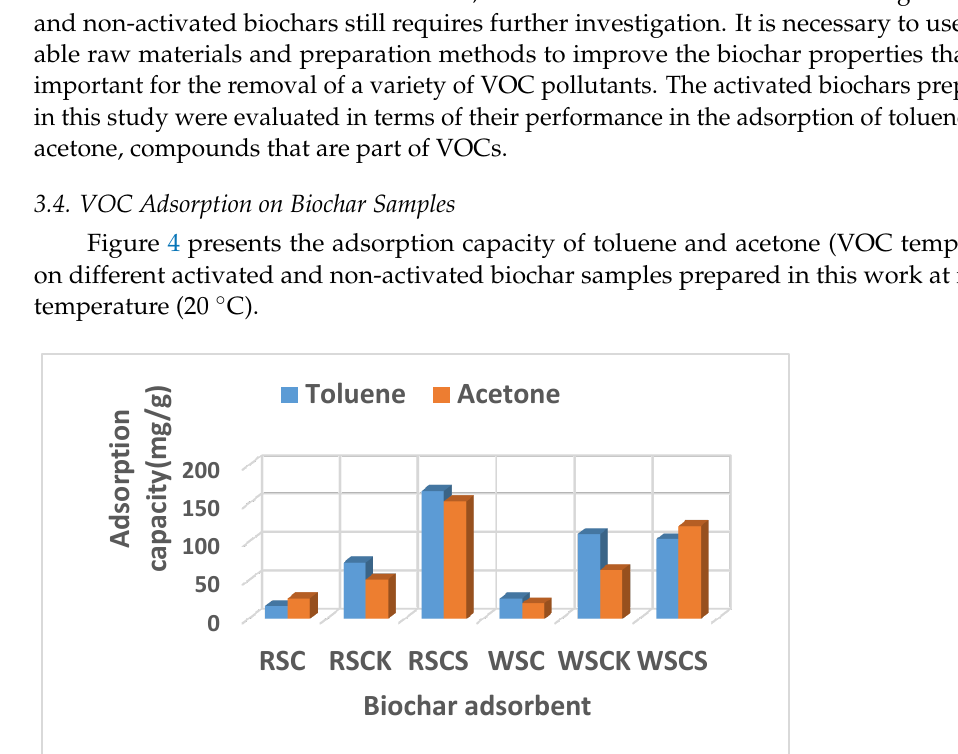
Figure 4. The adsorption capacity of toluene and acetone (VOCs) on different activated and non- activated biochar samples at room temperature (20 °C).